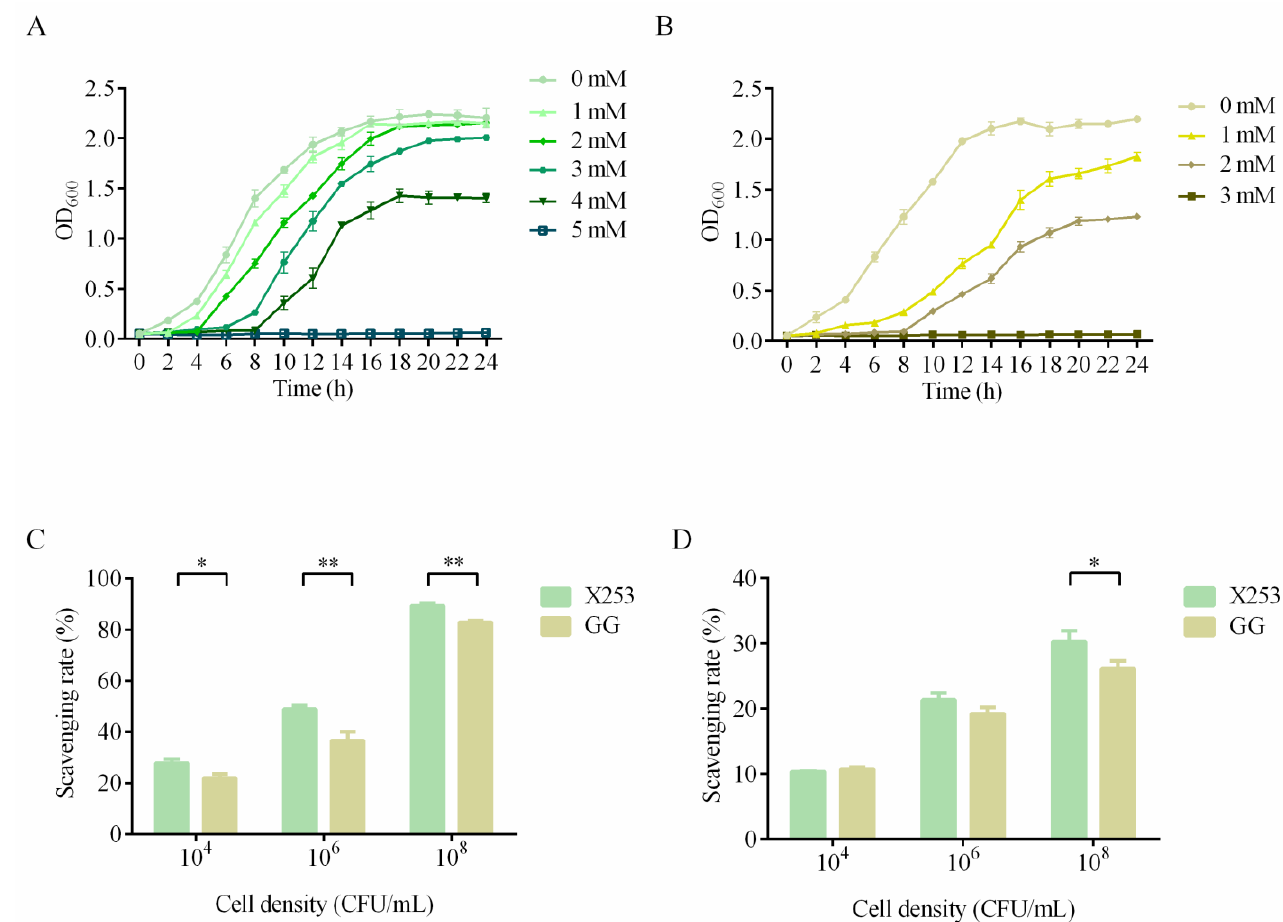
Figure 6. Comparative analysis of hydrogen peroxide tolerance and antioxidant capacity of L. rhamnosus X253 and L. rhamnosus GG: ( A , B ) Growth of L. rhamnosus X253 ( A ) and L. rhamnosus GG ( B ) in MRS broth containing different concentrations of hydrogen peroxide. ( C , D ) Scavenging rates of DPPH ( C ) and hydroxyl radicals ( D ) by bacterial suspensions with different densities (10 4 , 10 6 ,